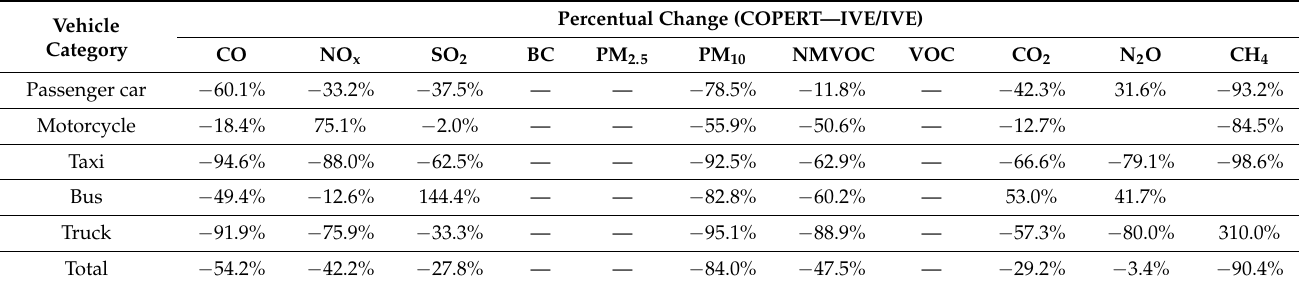
Table 4. Change of emissions between the IVE/top-down and the COPERT/top-down EIs [(COPERT—IVE)/IVE]. Vehicle Category